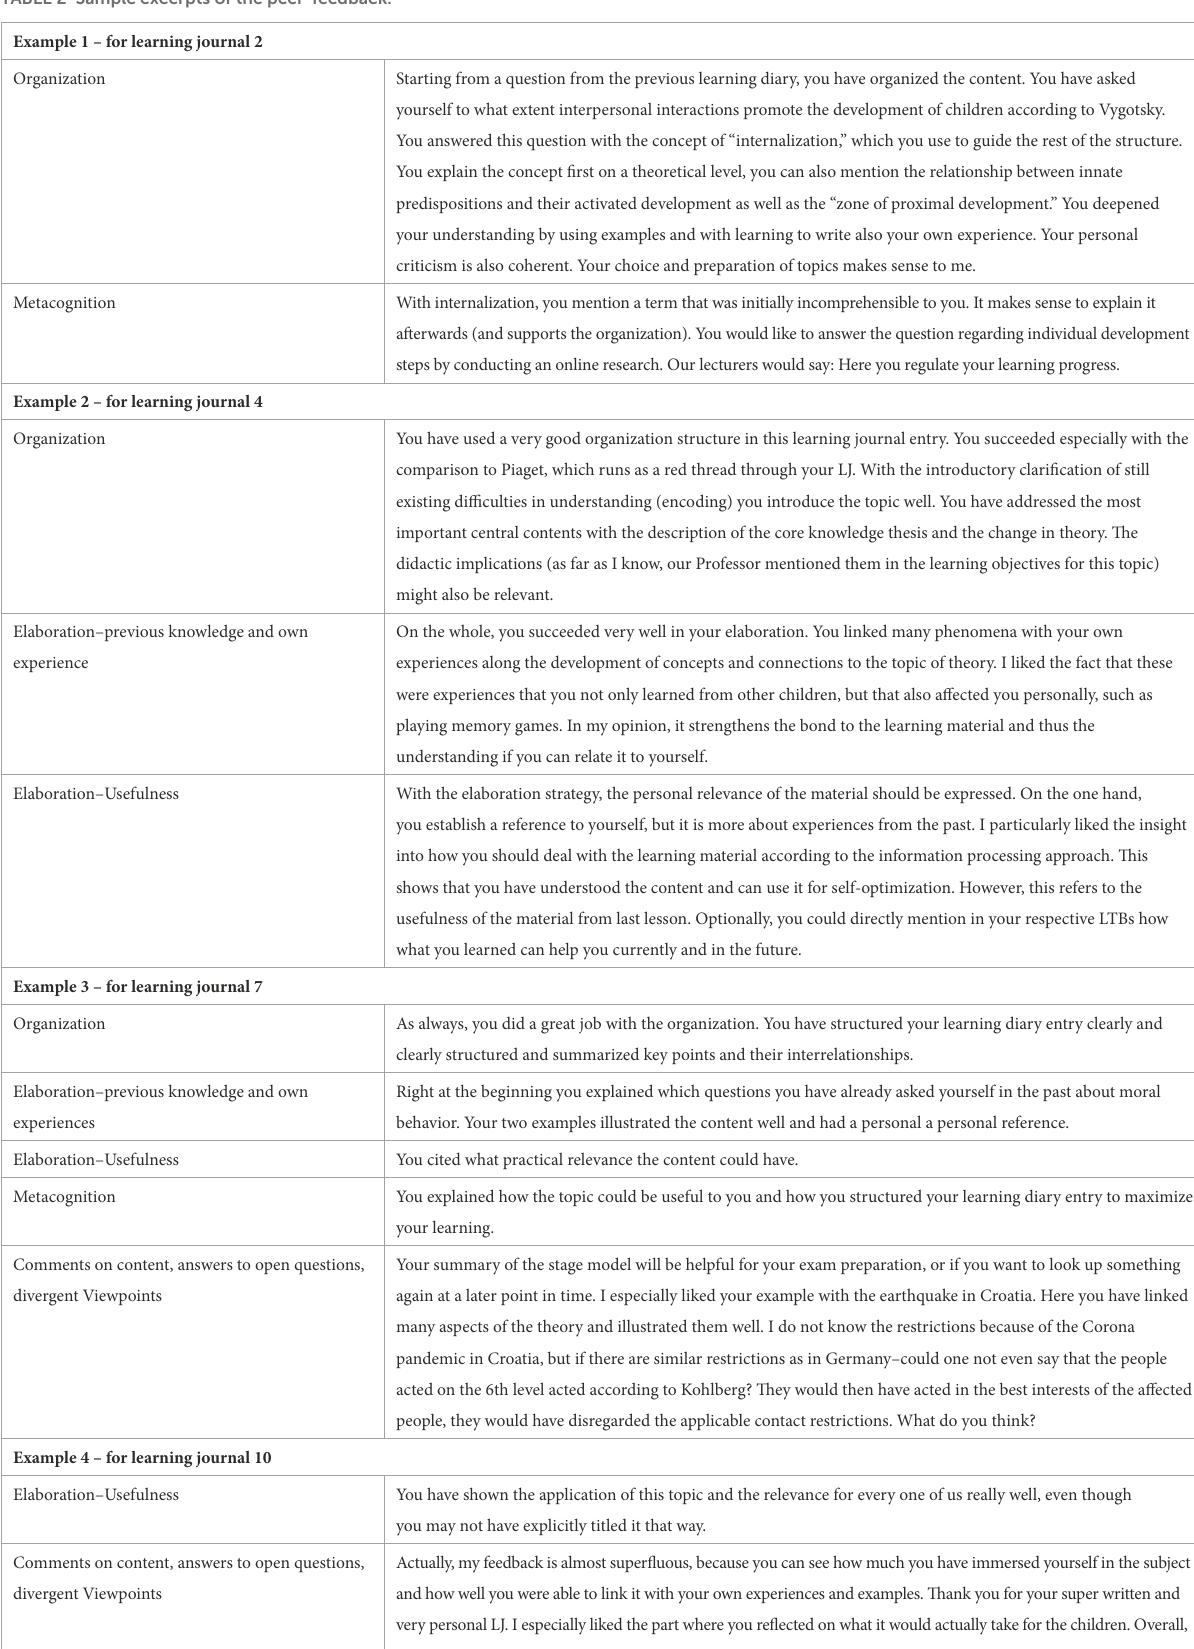
TABLE 2 Sample excerpts of the